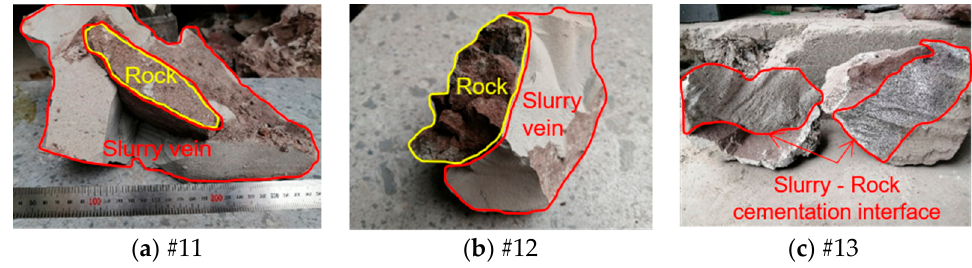
Figure 17. Concretion fragment of Groups #11–13.